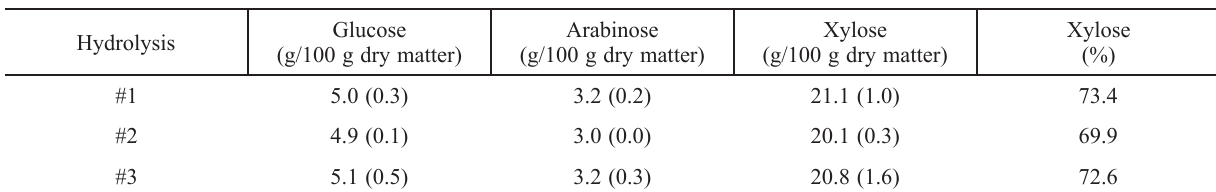
Table 4 – Total sugar yields in g/100 g dry matter and xylose yields (% of the theoretical) of corn stover sulfuric acid hydrolysis in hydrolyzate recycling. The hydrolyzate recycling experiments were carried out at 140 °C reaction temperature, 40-minute reaction time and 7 % (w/w) dry matter. Standard deviations are calculated from duplicates.